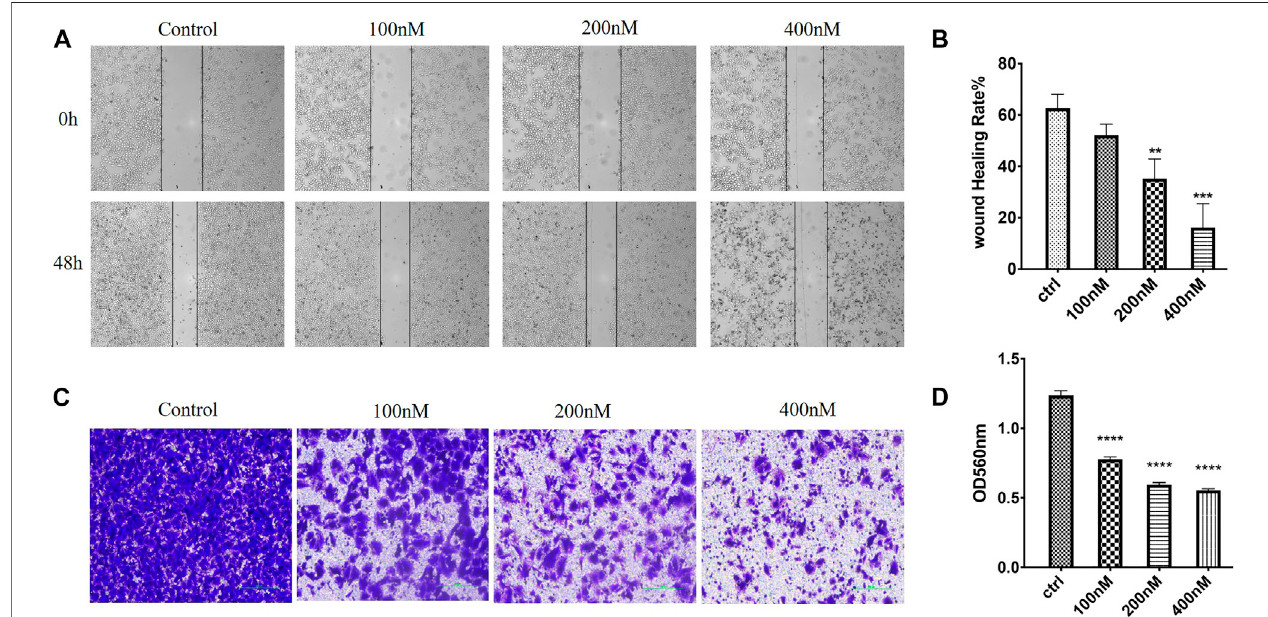
FIGURE 9 | Effects of 7m on human breast adenocarcinoma (MCF-7) cell migration and invasion in vitro . (A) Images of MCF-7 cell migration inhibited by 7m determinedinwoundhealingassay. (B) Inhibitoryratesof7monMCF-7cellmigration. (C) Inhibitionofcellularinvasionby7minTranswellassay. (D) Quantitativeanalysis of the migration ability of MCF-7 cells after the treatment of 7m. The experiments were repeated three times, and results are indicated as means ± SD. * p < 0.05, ** p < 0.01; *** p < 0.001 vs. untreated control.